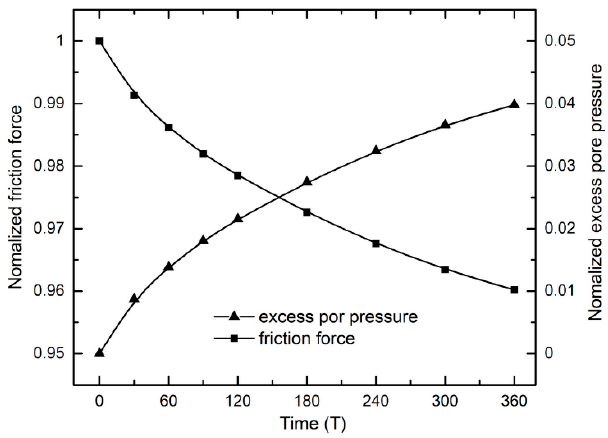
Figure 12. Normalized friction force on the external wall.